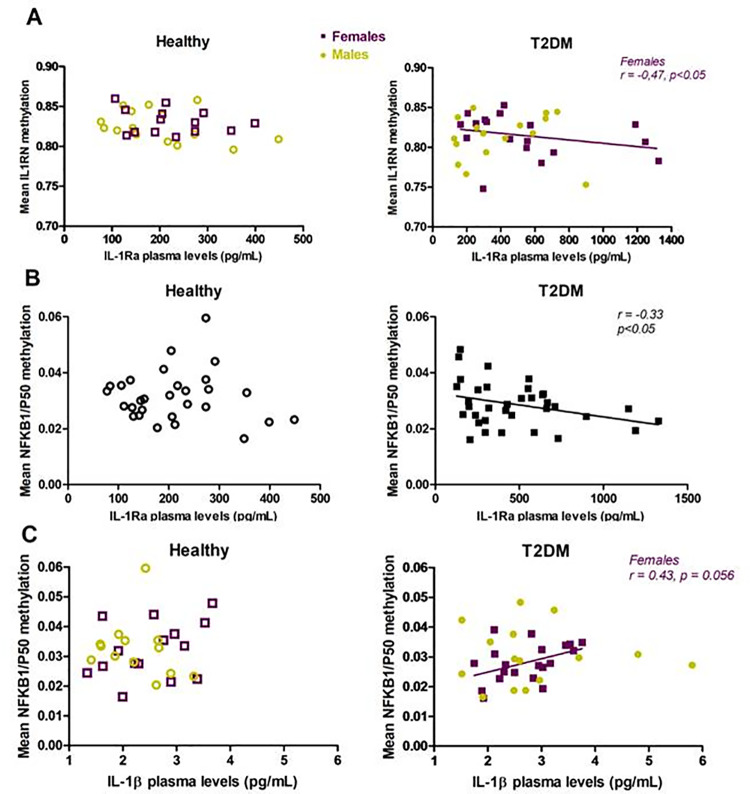
An association between mean DNA methylation and cytokine plasma levels in type 2 diabetes mellitus (T2DM) patients and healthy controls (Healthy).(A) Correlation between IL1RN promoter mean methylation level and IL-1Ra plasma levels in males (green) and females (violet); (B) Correlation between NFKB1 promoter mean methylation level and IL-1Ra plasma levels in all studied subjects (black); (C) Correlation between NFKB1 promoter mean methylation level and IL-1β plasma levels in males/females.